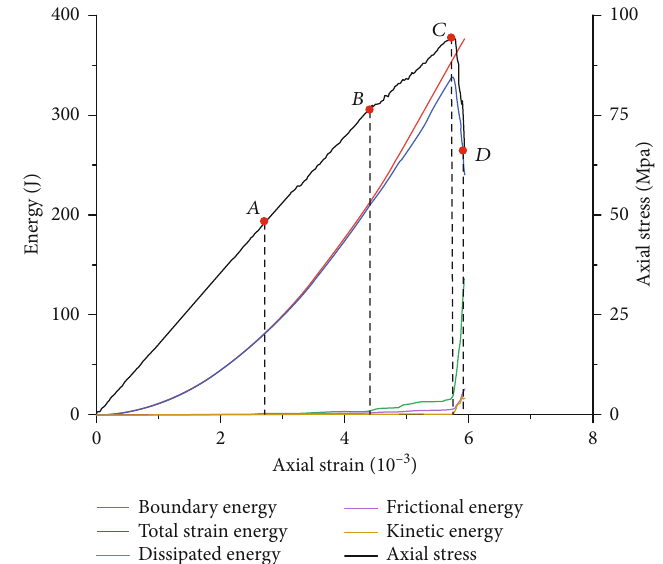
Figure 11: Relationship between energy and stress-strain of numerical model ( α = 45 ° , β = 60 °